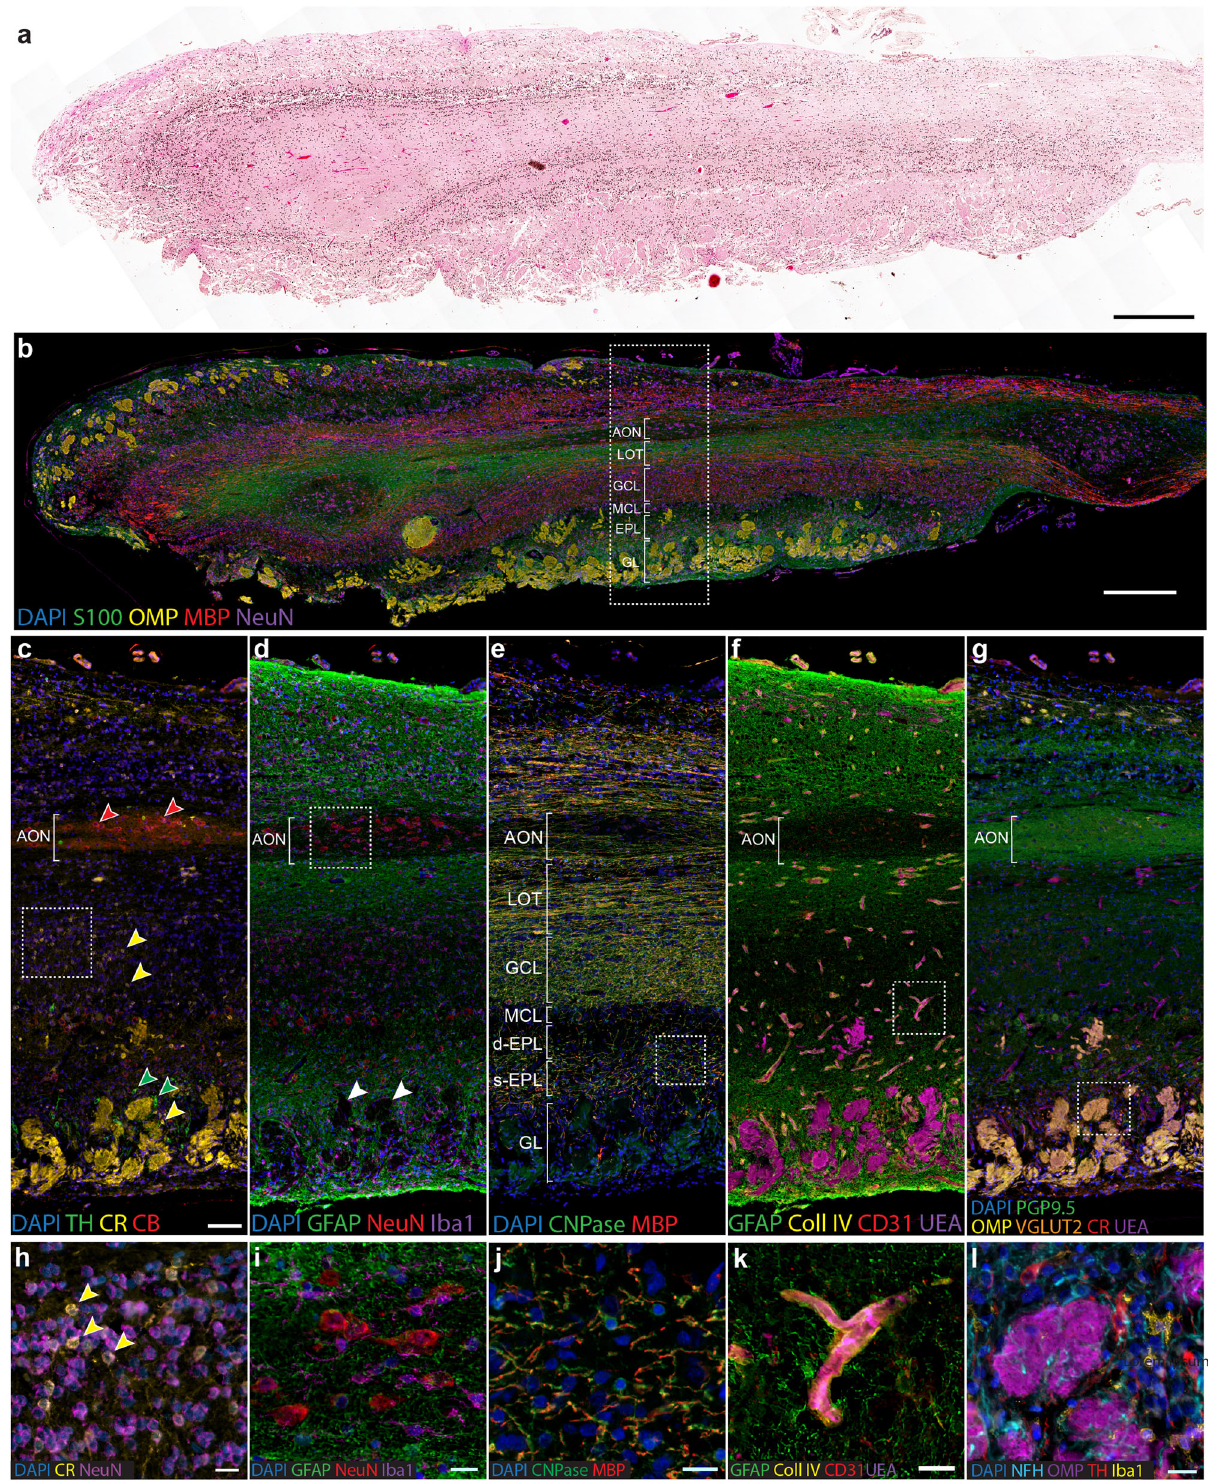
neocortical Lewy body